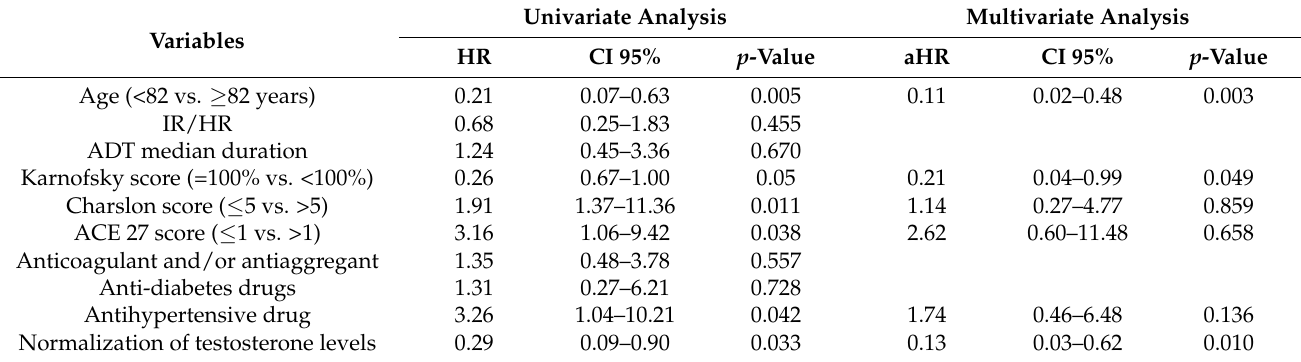
Table 2. Overall survival (OS) in older patients (groups A + B; n = 101). Univariate and multivariate analysis. Variables